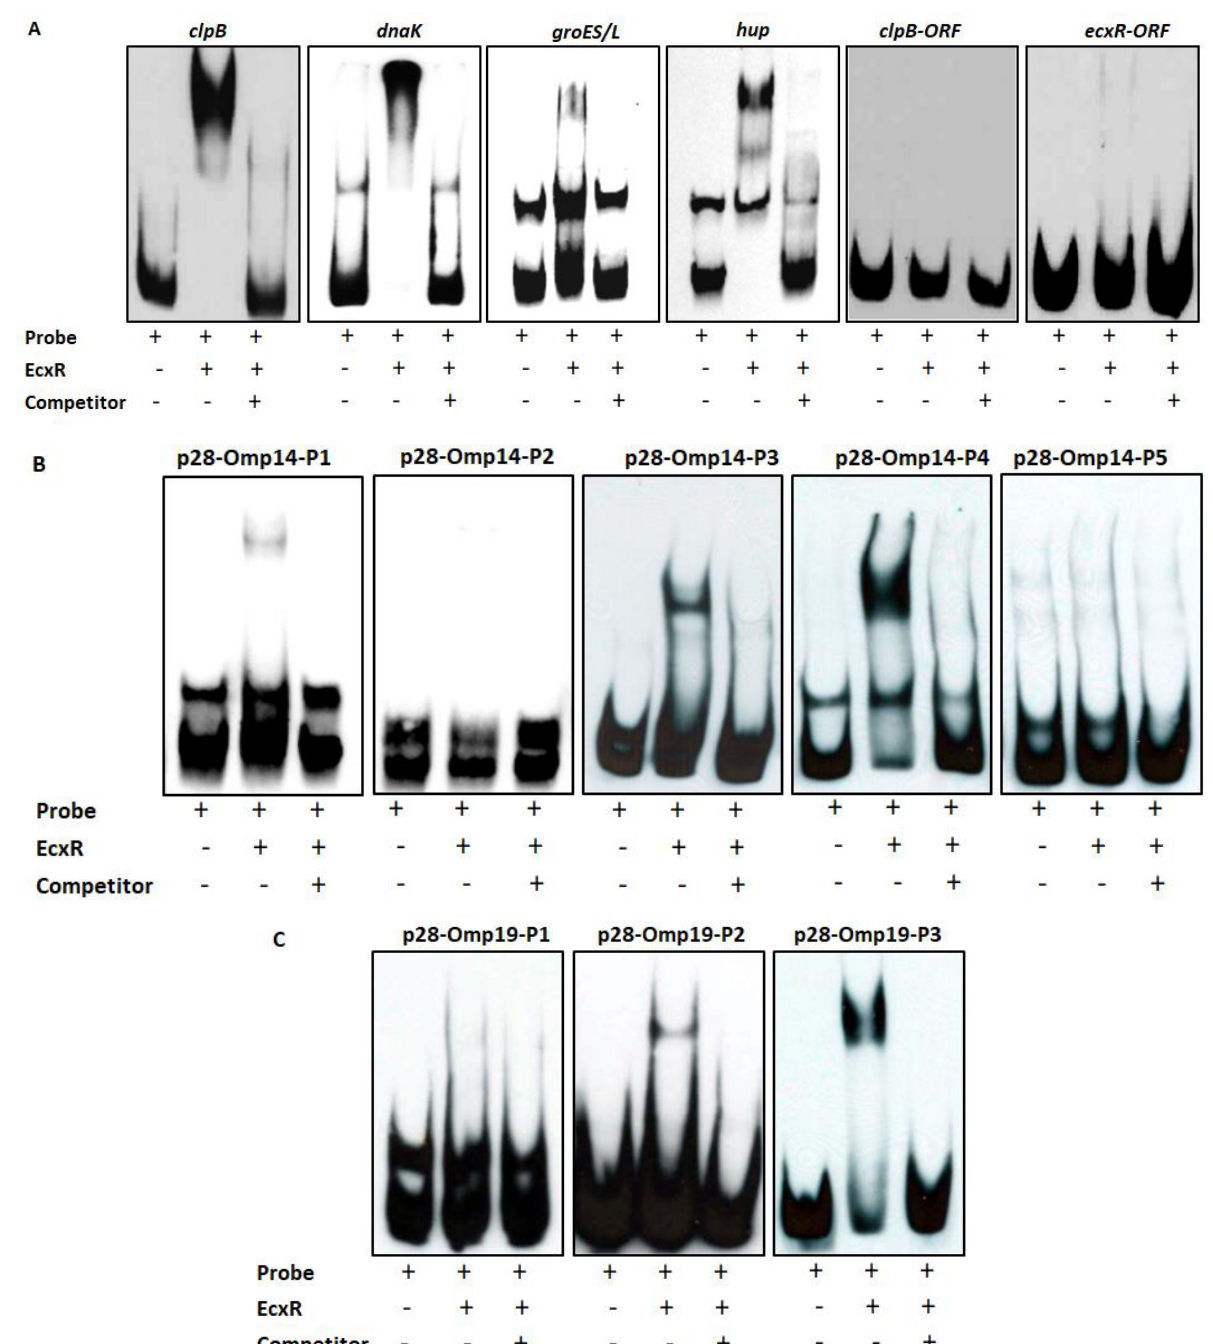
Figure 3. Electrophoretic Mobility Shift Assays (EMSAs) to assess the interaction of EcxR with different E. chaffeensis gene promoters. ( A ) From left to right, biotin-labeled probes of clpB, dnaK, groES/L and hup were incubated with recombinant EcxR. High excess cold competitor DNA (unlabeled) was added to show the specificity for protein-promoter interactions. Two DNA segments containing the coding region of dnaK (dnaK-ORF) and ecxR (ecxR-ORF) were used as additional controls to define the specific interactions of EcxR (far right data panels). ( B ) Biotin-labeled probes of different p28-Omp14 promoter segments (as described in Figure S2A), were used in the EMSA analysis to identify specific regions of these two gene promoters with EcxR. ( C ) Similarly, biotin-labeled probes of different p28-Omp19 promoter segments were used in the EMSA analysis.